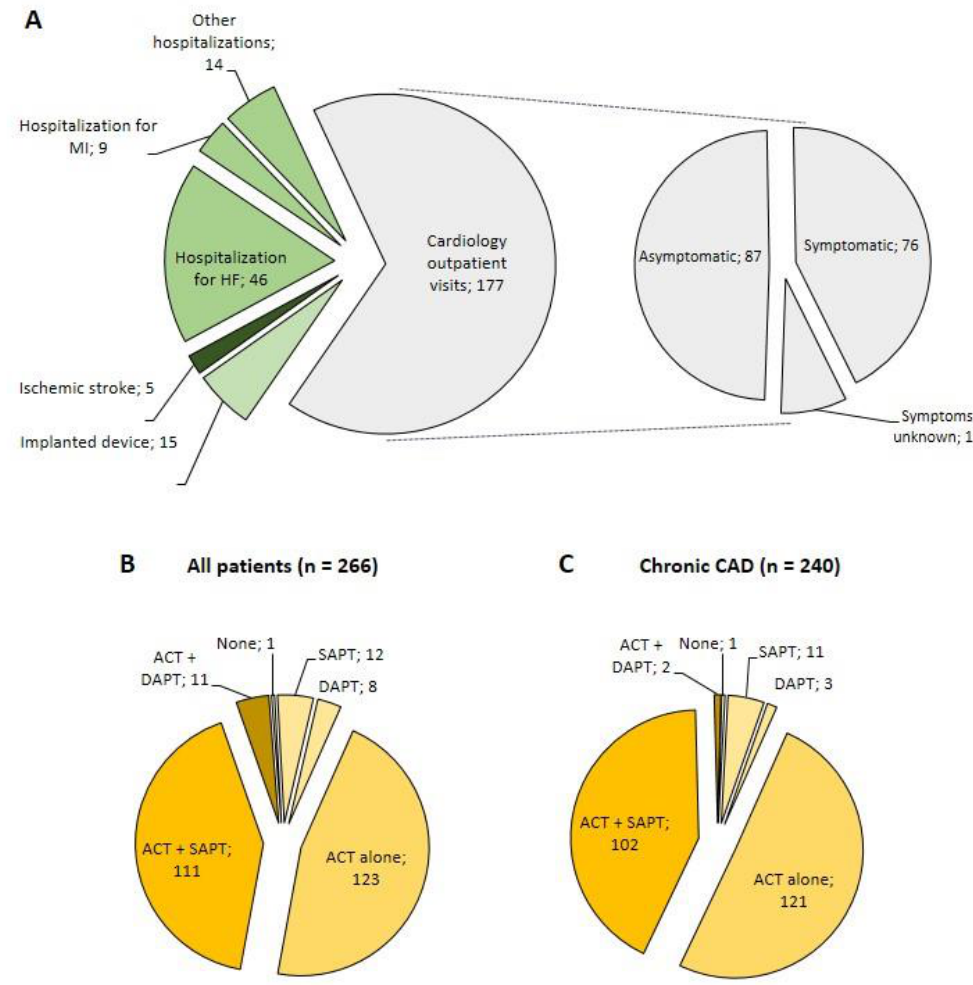
Figure 3. Diagnostic circumstances and antithrombotic management of incident atrial fibrillation (AF) in coronary artery disease (CAD) outpatients. ( A ) Diagnostic circumstances of incident atrial fibrillation (AF) in coronary artery disease (CAD) outpatients. HF, heart failure; MI, myocardial infarction ( B ) Antithrombotic strategy in all coronary artery disease (CAD) outpatients with incident atrial fibrillation (AF); ACT, anticoagulant therapy; DAPT, dual-antiplatelet therapy; SAPT, single-antiplatelet therapy. ( C ) Antithrombotic strategy in patients with incident AF in a context of chronic CAD (i.e., patients without recent (<1 year) history of myocardial infarction and/or percutaneous coronary intervention). Table 3. Comparison of patients receiving anticoagulant therapy (ACT) alone vs. ACT and antiplatelet therapy (APT) ( n = 225 patients with incident atrial fibrillation (AF) and without a recent (<1 year) history of myocardial infarction (MI) or percutaneous coronary intervention (PCI)). ACT alone ( n = 121 ) ACT + APT ( n = 104 )